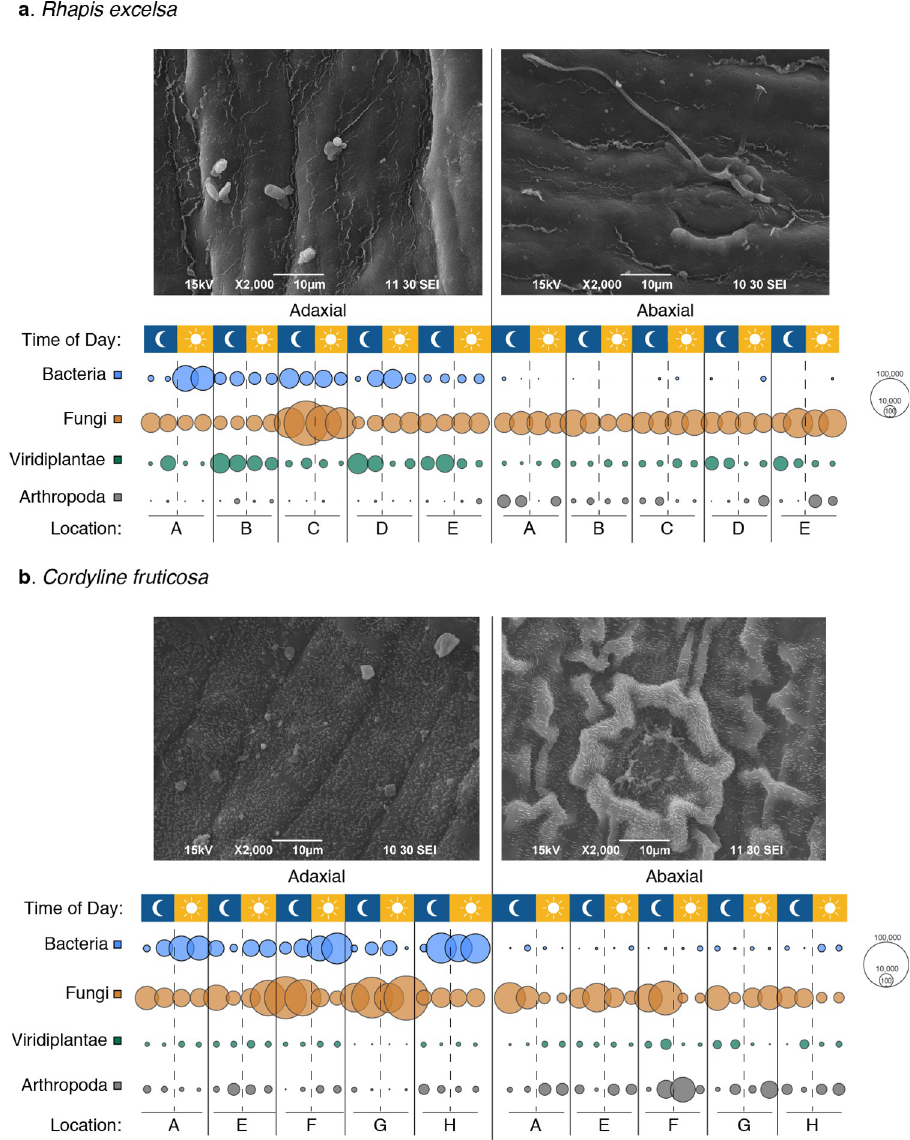
Fig 1. SEM images and bubble charts of microbes, plants and arthropod-related reads on the adaxial and abaxial leaf surfaces. The bubble sizes correspond to the relative abundance of reads assigned to bacteria, fungi, plant host and arthropods in the comparative metagenomic analyses. Reduction in bacterial read counts observed on the abaxial surface as compared to the adaxial surface in contrast to Fungi, Viridiplantae and Arthropoda reads on the leaf surfaces of (a) R . excelsa and (b) C . fruticosa . The moon and sun symbols refer to the time of sampling (midnight and noon), while the letters refer to the sampling location in S1 Fig. The SEM images were original images captured by Chee Peng Ng and David Liebl from the IMB-IMCB Joint Electron Microscopy Suite (A � STAR Singapore).